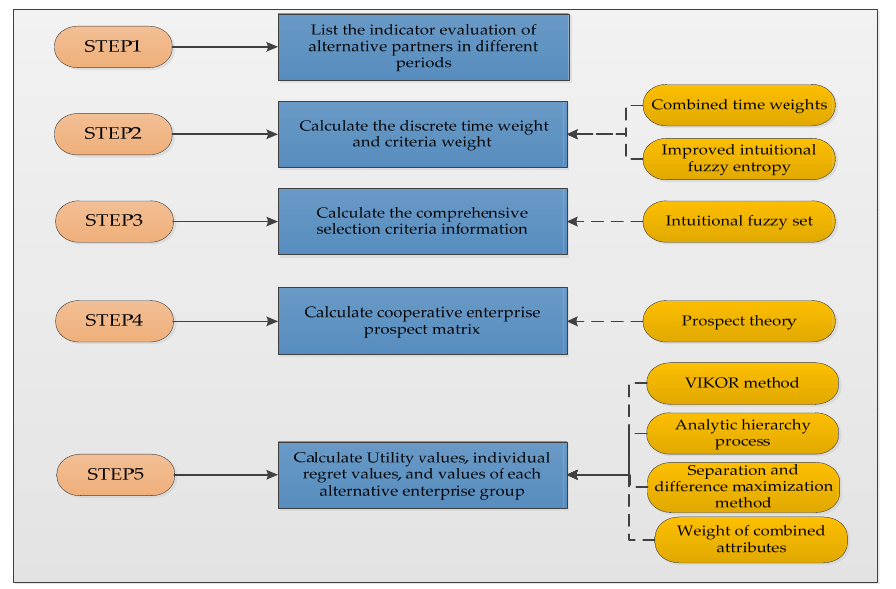
Figure 4. Methodological framework of choosing digital green innovation partner for PCEs.